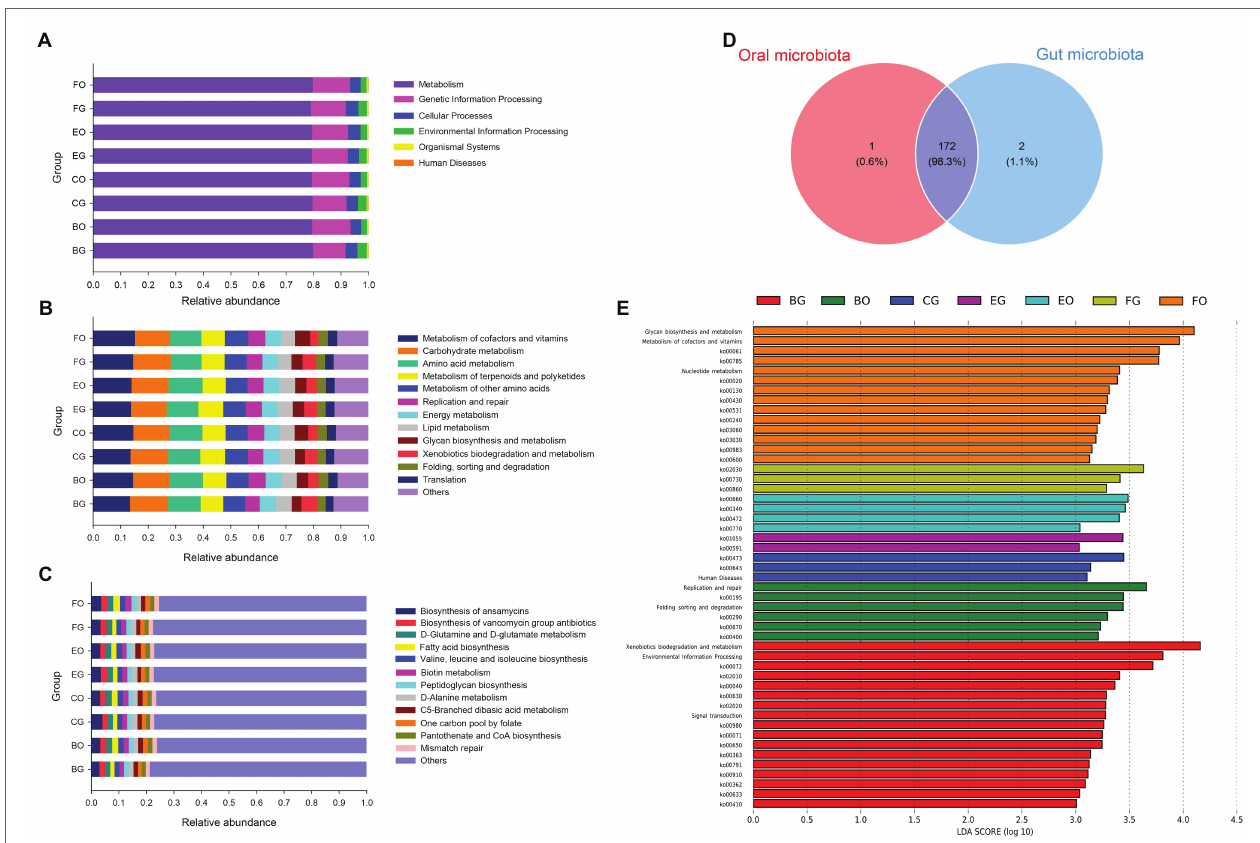
FIGURE 6 | Gene functional categories based on 16S RNA in the gut microbiota at top (A) , second (B) , and third (C) levels of relative abundance, and the Venn diagram of functional gene between the oral and cloacal samples (D) . LDA scores reflect the differences in relative abundance among eight groups of microbiota samples (E) . Each color in a plot indicates one gene function. Detailed descriptions are shown on the right side of each plot. The colors for others in Plots B and C indicate all other gene functions not listed in these two plots. See Figure 1 for the definition of every